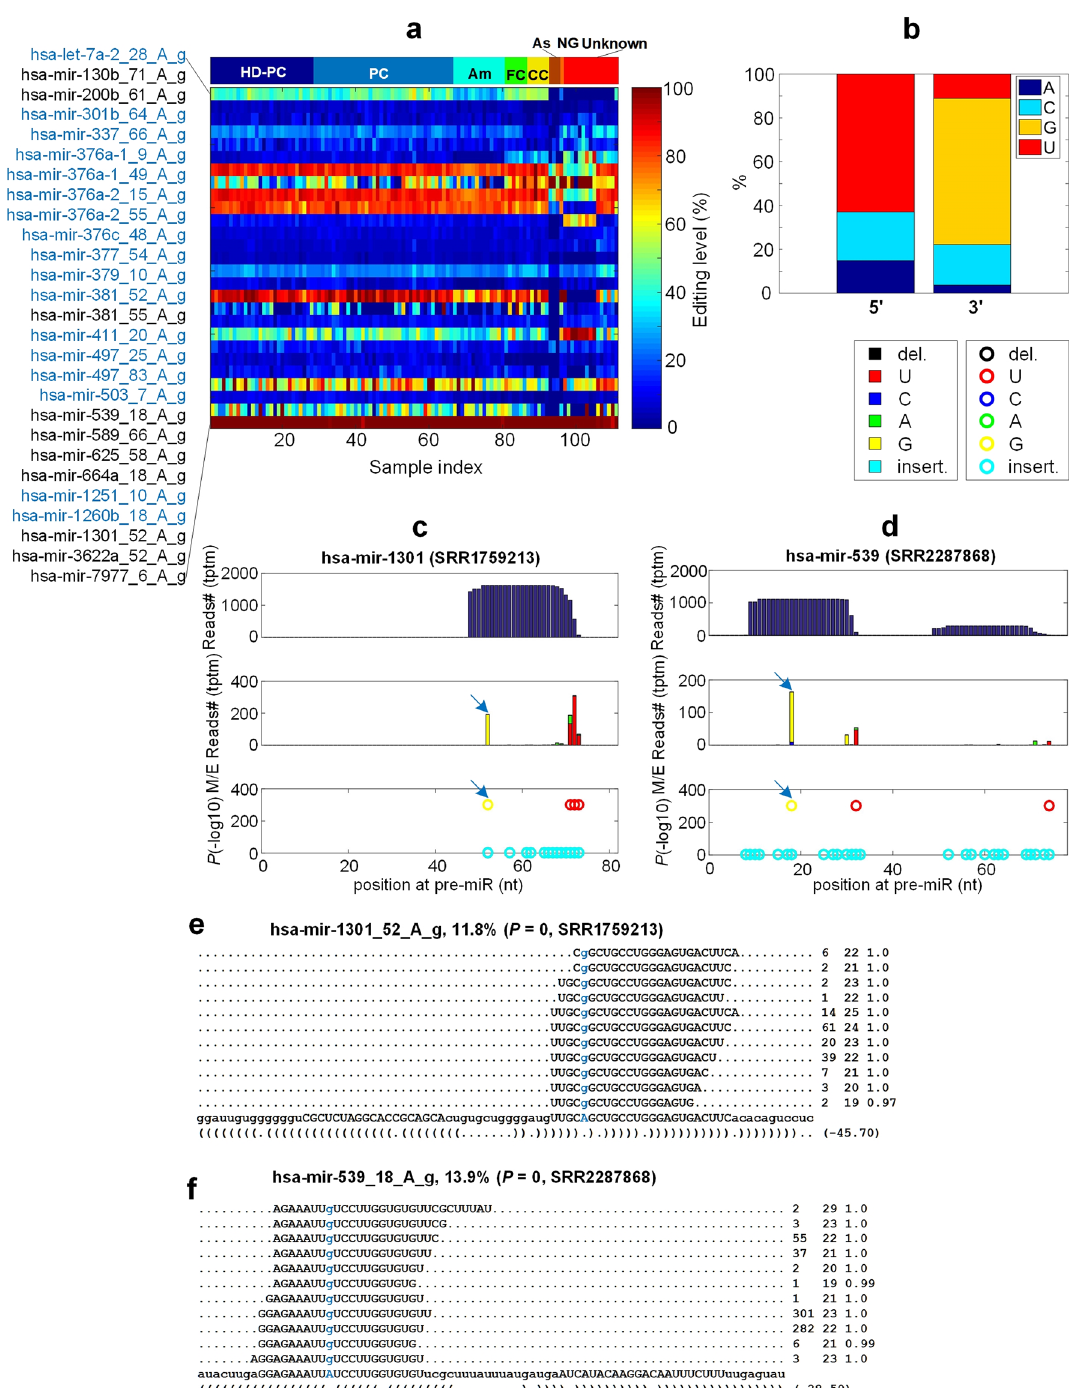
Figure 2. The detailed information of A-to-I editing sites in miRNAs of HD samples. ( a ) The editing levels of 27 A-to-I editing sites in 111 selected sRNA profiles. The tissues from left to right are prefrontal cortex (BA9) regions of HD patients (HD-PC), prefrontal cortex (BA9) regions of healthy controls (PC), amygdala regions of healthy controls (Am), frontal cortex regions of healthy control (FC), corpus callosum regions of healthy controls (CC), astrocytes of healthy controls (As), temporal neocortex gray matter region from healthy control (NG) and unknown regions from healthy controls (Unknown). The sites with blue names are conserved in mammals. ( b ) The base distribution of A-to-I editing sites at 5’ and 3’ end of the mature miRNAs. ( c ) The MiRME map of hsa- mir-1301 in one of the PC samples selected (SRR1759213). The three panels from top to bottom displayed the total number of reads (in Tags Per Ten Million sequencing reads, tptm), the number of M/E reads with variations (in tptm), and P -values of the M/E events shown in the central panel, respectively. ( d ) The MiMRE map of hsa-mir-539 in one of the FC samples selected (SRR2287868). ( e ) The details of hsa-mir-1301_52_A_g in SSR1759213. ( f ) The details of hsa-mir-539_18_A_g in SRR2287868. In Part (e)-(f), the edited nucleotides are shown in blue. And the first number on the right indicates the number of raw sequencing reads, the second number indicates the length of the reads, and the third number indicates the weight of the reads on this locus as calculated by the cross- mapping correction algorithm 84